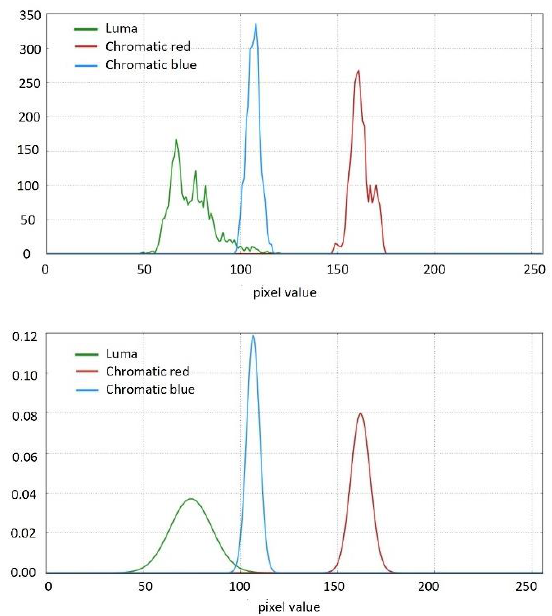
Figure 5. Histograms of one class and fitted